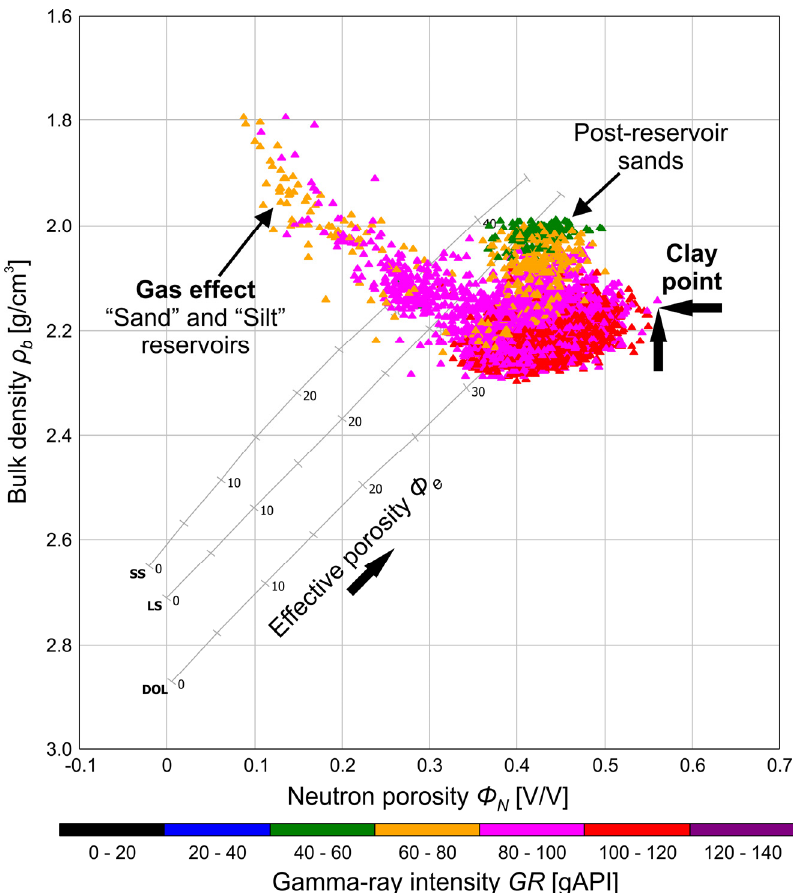
Figure 5. Neutron–density crossplot corresponding to the Pliocene (“Sand”, “Silt”, and post-reservoir) deposits of field “A” and including data from A-1 and A-2 wells (7180 data levels). A caliper cut-off ( d < 9 in) was used to eliminate the bad hole levels. The approximate location of a clay point ( φ Nclay , ρ clay ) representative for the entire Pliocene sequence is indicated. SS, LS, and DOL are theoretical ρ b = f ( φ N ) response curves for the main reservoir lithologies (sandstone, limestone, dolomite) [32].